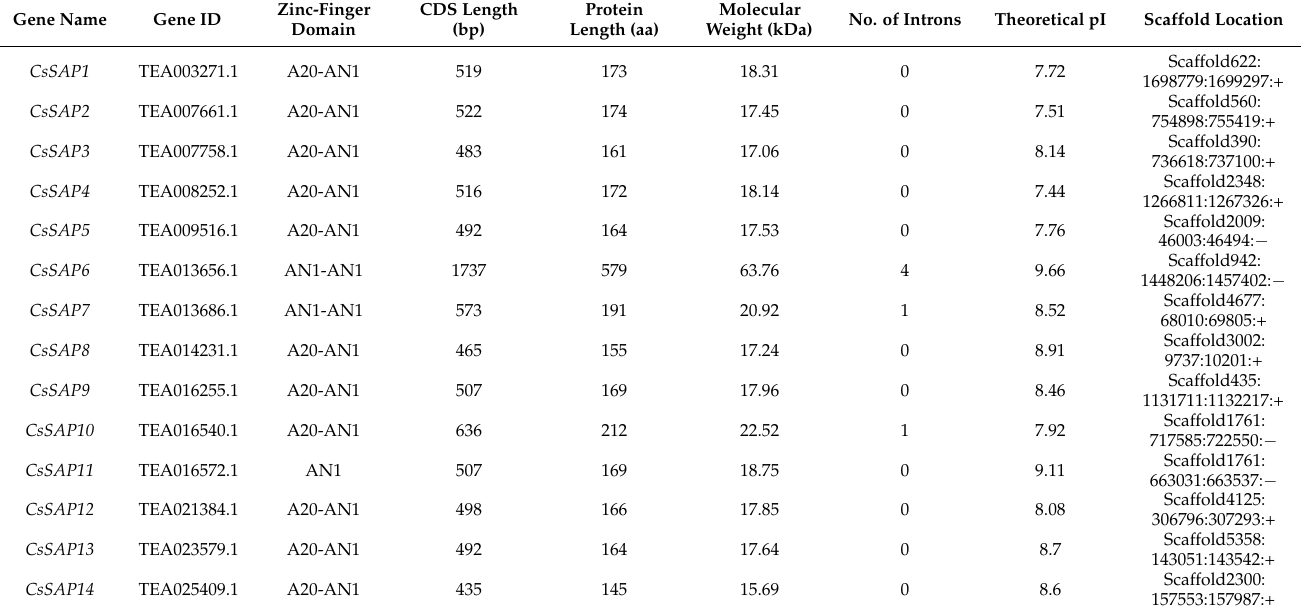
Table 1. Properties of CsSAPs identified from tea plant genome.